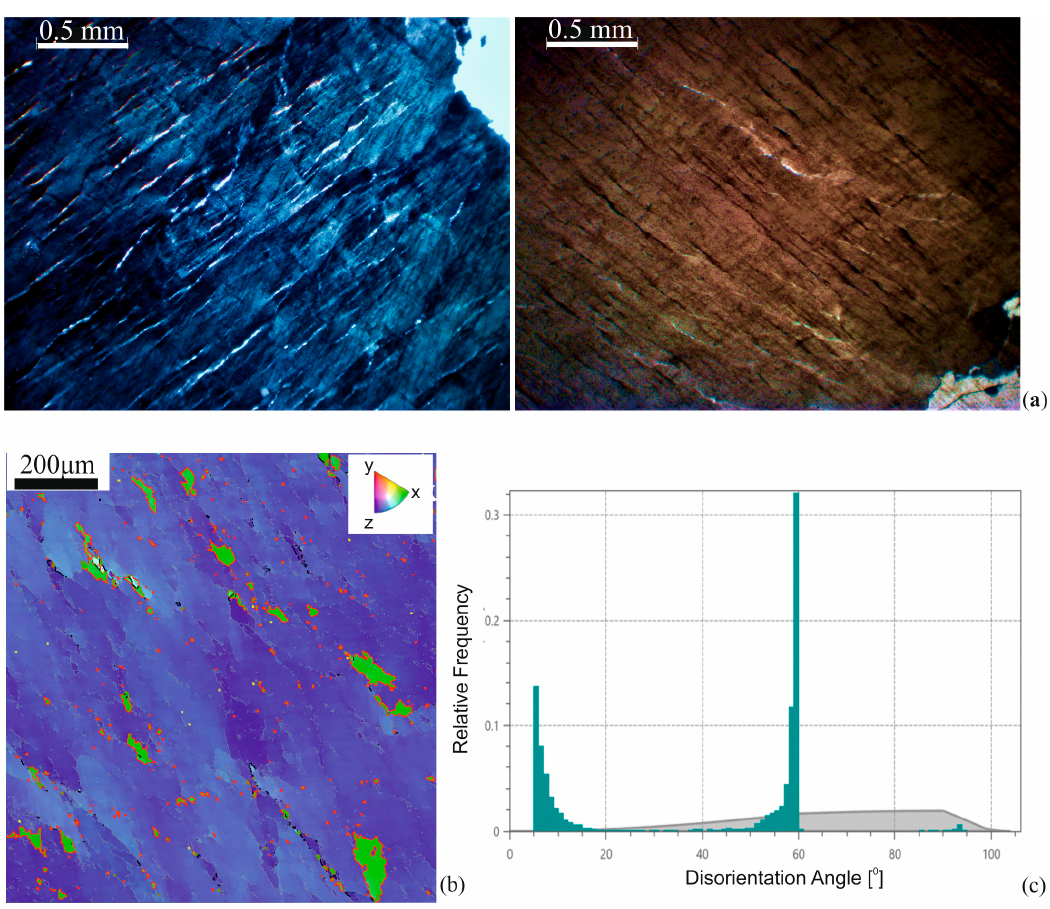
Figure 7. Features of the microstructure of vein quartz type B: ( a ) optical micrography of quartz with the intensive development of subunits; ( b ) the processed EBSD band contrast (BC) + inverse pole figure (IPF) map with the color coded boundaries indicating the angle of boundary misorientation; and ( c ) the disorientation angle distribution and theoretical curve (gray color) demonstrating the development of low-angle and high-angle boundaries of the Dauphiné twins.